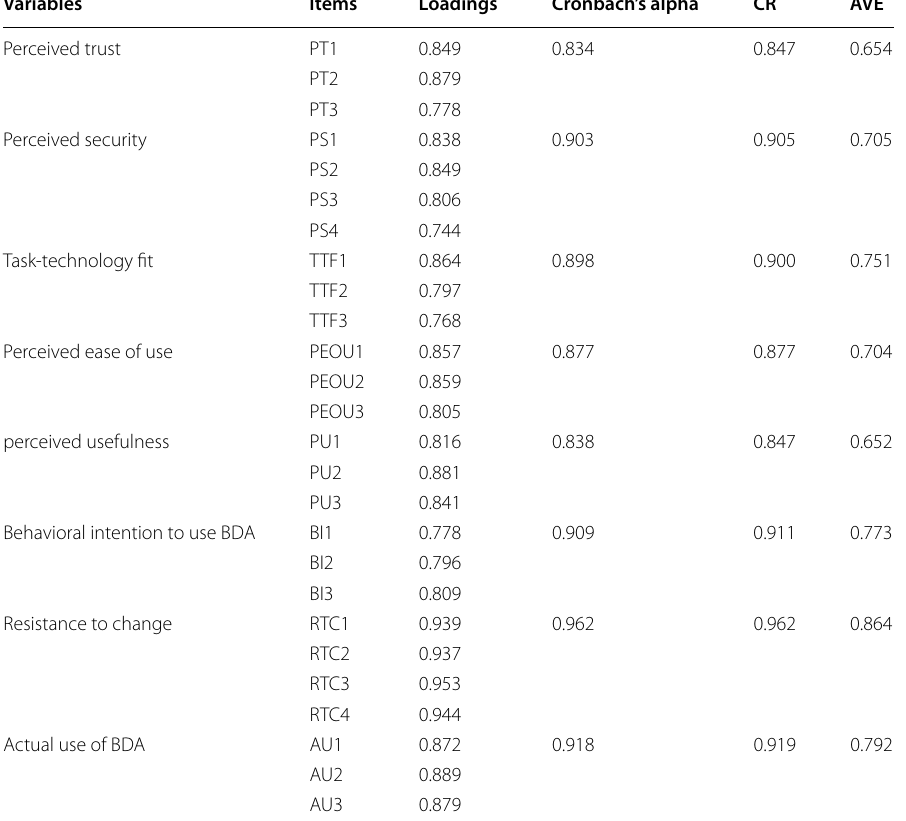
Table 3 Results of factor loadings, validity, and reliability Variables Items